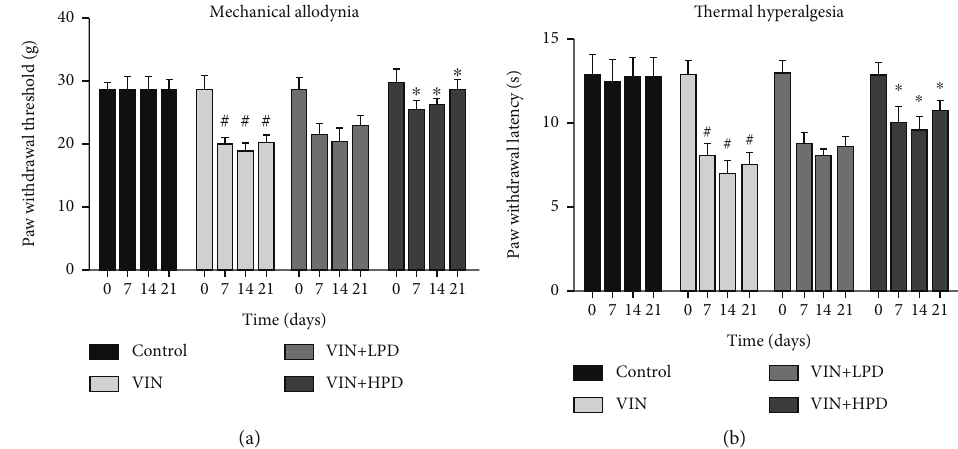
Figure 6: Polydatin relieves pain hypersensitivity in VIN-induced rats. The mechanical allodynia (a) and thermal hyperalgesia (b) were measured in di ff erent groups after 0, 7, 14, and 21 days of VIN administration. Results were expressed as mean ± SD ( n = 6 ). # P < 0 : 05 , the VIN group compared with the control group; ∗ P < 0 : 05 , the VIN+HPD group compared with the VIN-treated group.